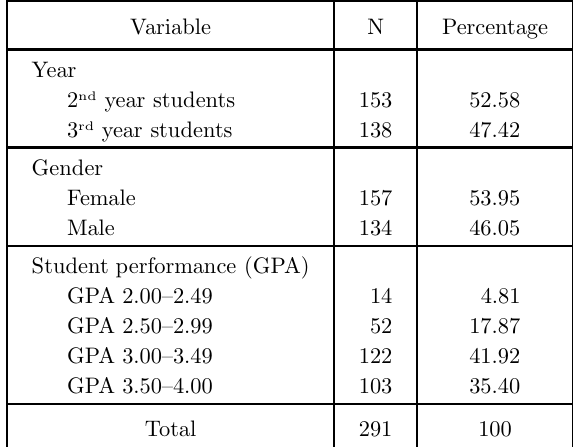
Table 1. Characteristics of respondents by academic level, gender, and per-